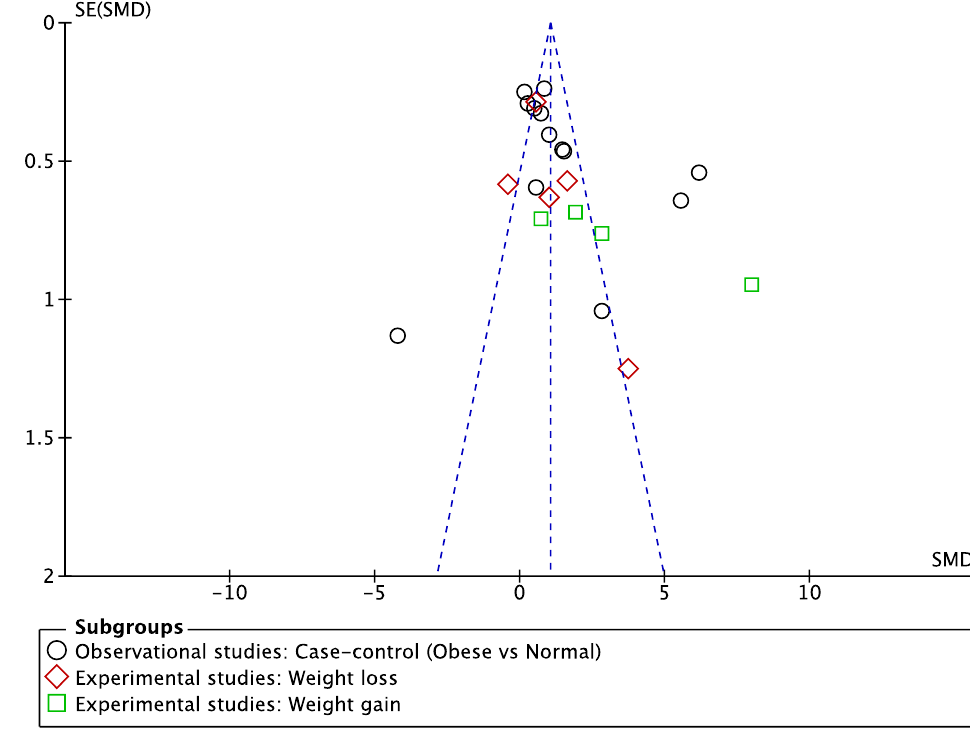
Figure 2. Funnel plot of meta-analysis with a 95% CI.